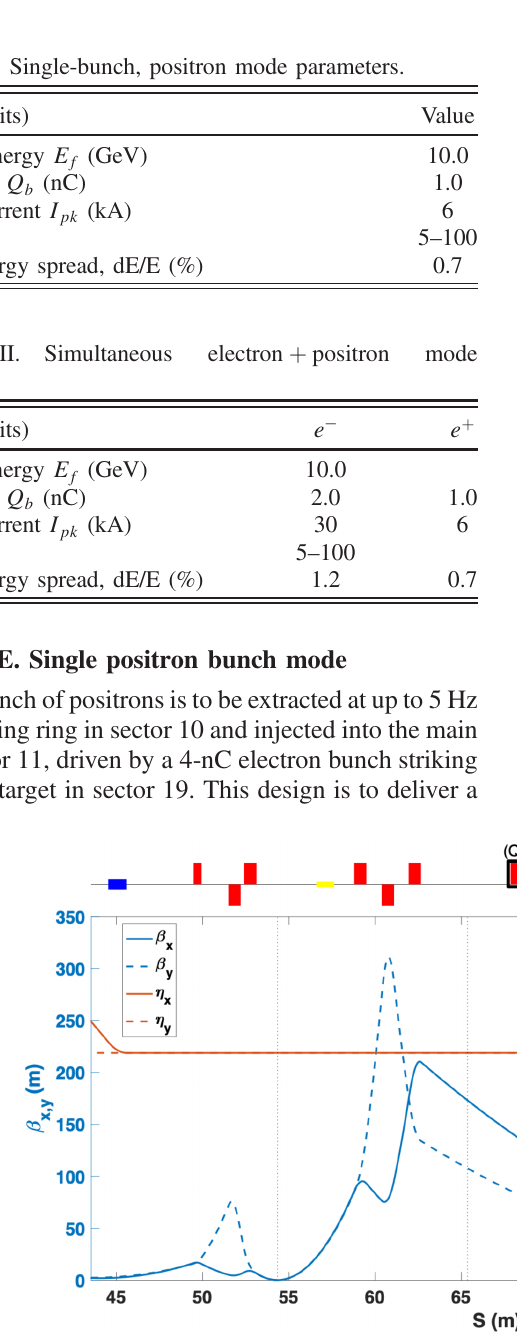
FIG. 3. Beam optical functions in the interaction region with focusing set for the alternative, upstream IP